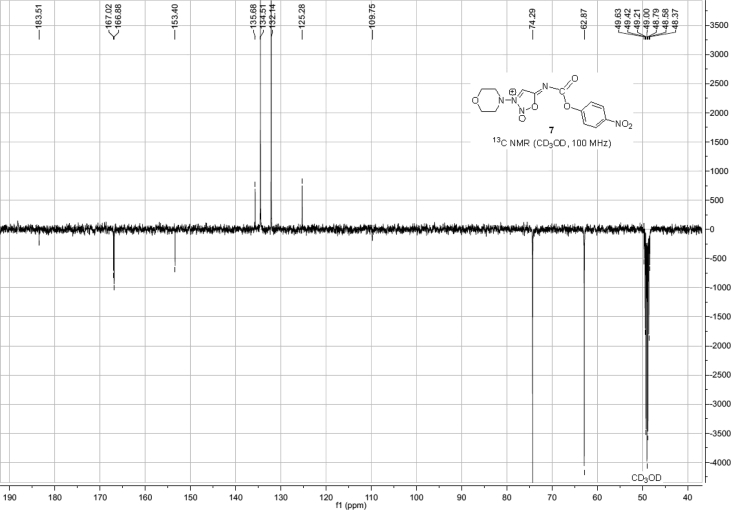
13C NMR spectra of compound 7.